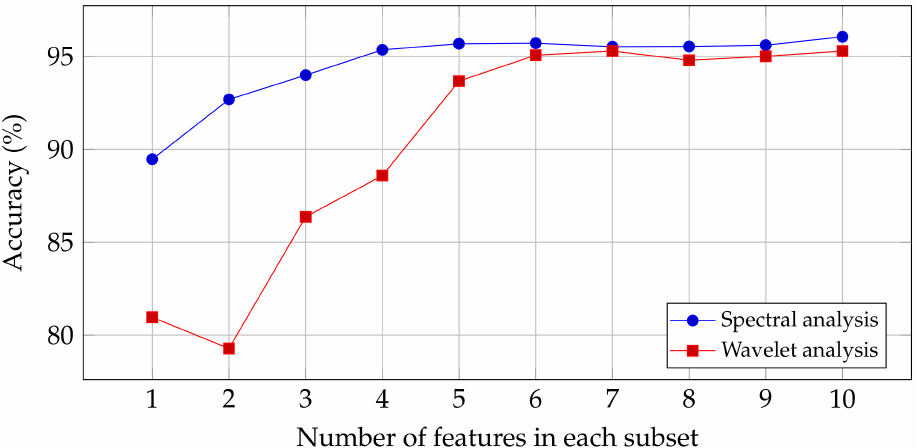
Figure 5. Accuracy of classification and average normalized computation time for different subsets of